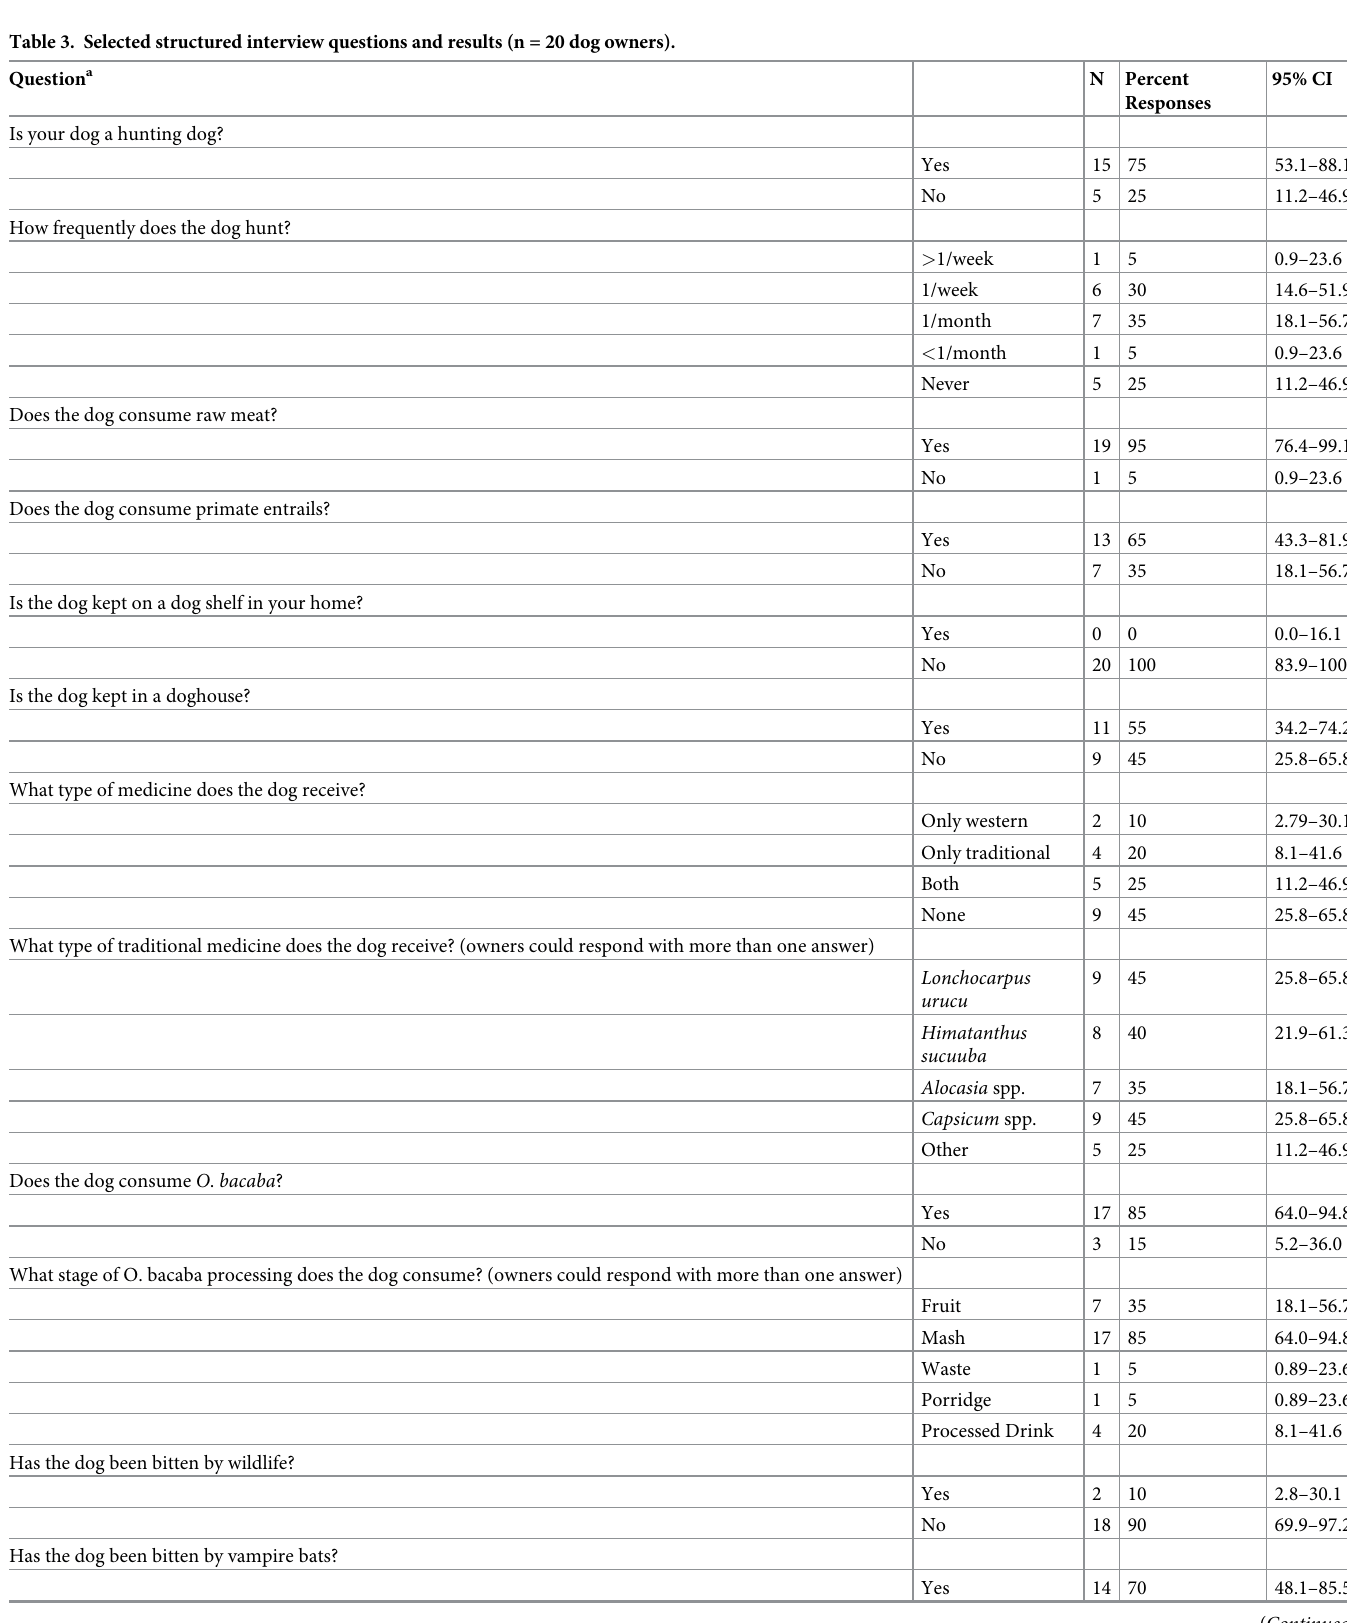
Table 3. Selected structured interview questions and results (n = 20 dog